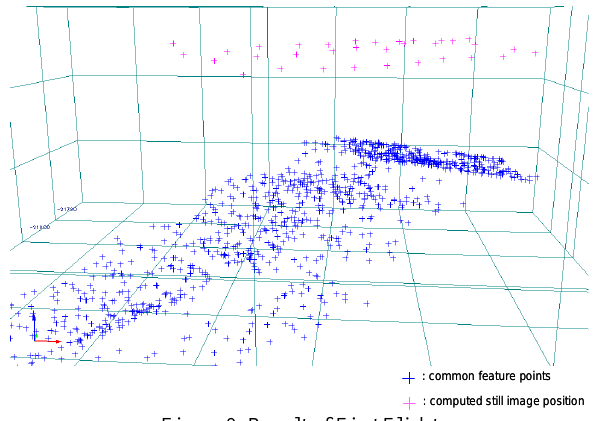
Figure 9. Result of First